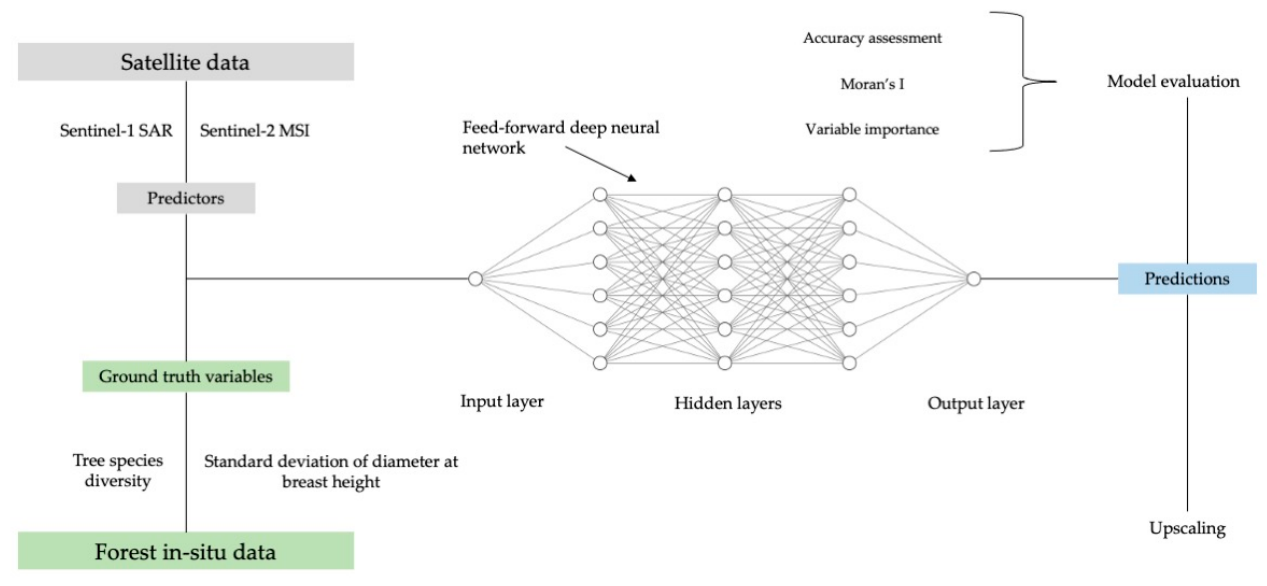
Figure 5. Workflow and architecture of the deep neural